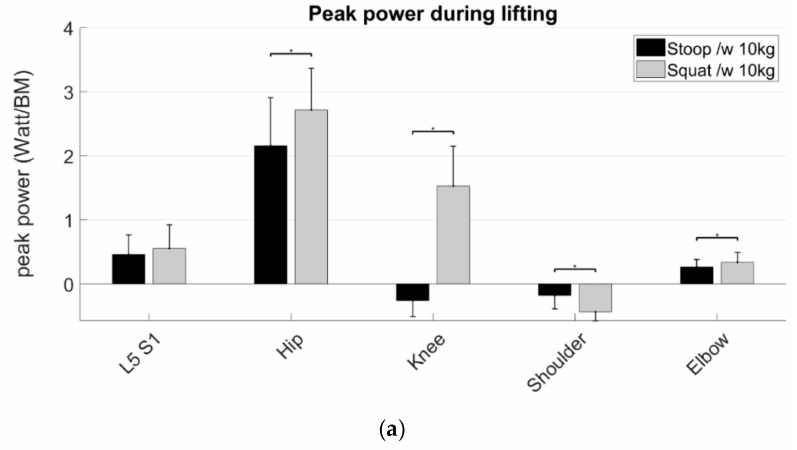
Figure A4. Moment impulse normalized to body mass during the two di ff erent lifting techniques (stoop and squat) with the 10 kg box. Statistical significant di ff erences ( α < 0.05) between the handling phases are indicated with three dots, and statistical meaningful di ff erences between technique and loads are indicated with one dot. Error bars indicate standard deviations. ( a ) Moment impulse during the lifting phase in the five di ff erent joints (L5S1, hip, knee, shoulder and elbow); ( b ) moment impulse during the lowering phase in the five di ff erent